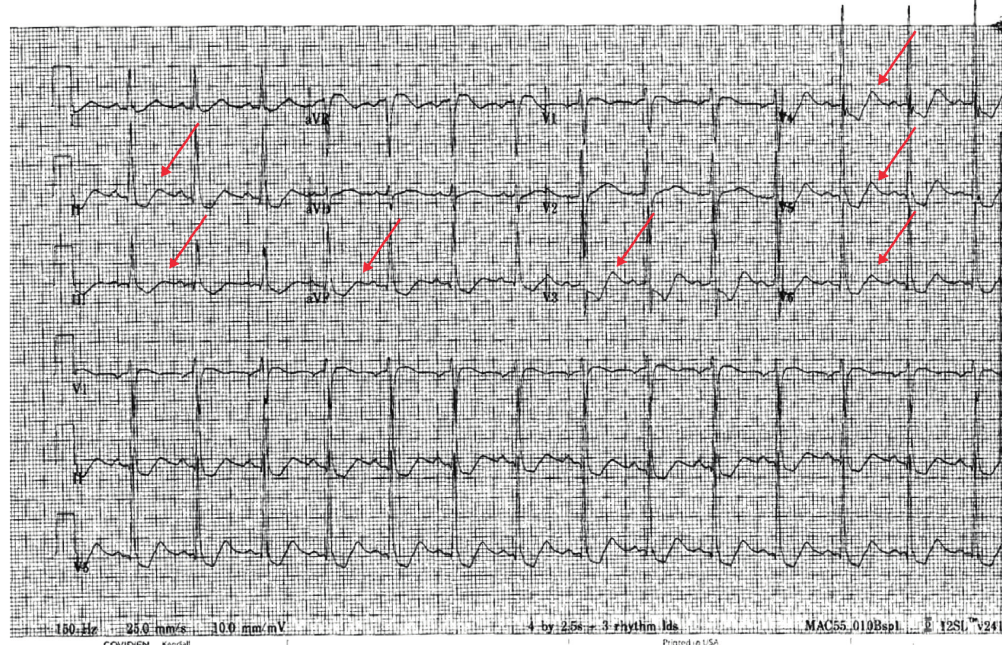
Figure 1: Admission ECG showing inverted T-waves followed by U-waves (red arrows) in leads II, III, AvF, and V3–V6, a sign of